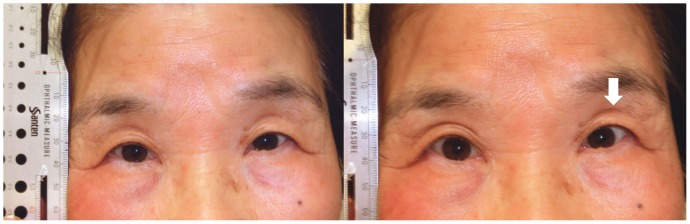
An older subject judged to have a DUES-like appearance.A healthy 72-year-old female with a DUES-like appearance of the left eye. An UES was judged to be present when she had natural open eyes, while other signs were judged to be negative.